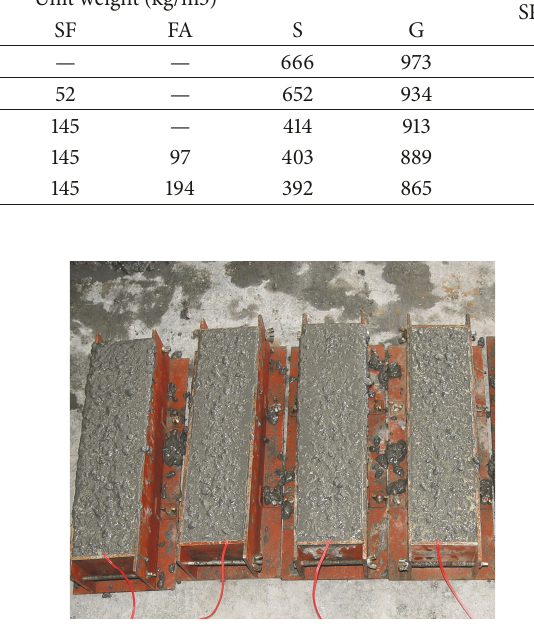
Figure 1: Drying shrinkage test specimens cast in molds.